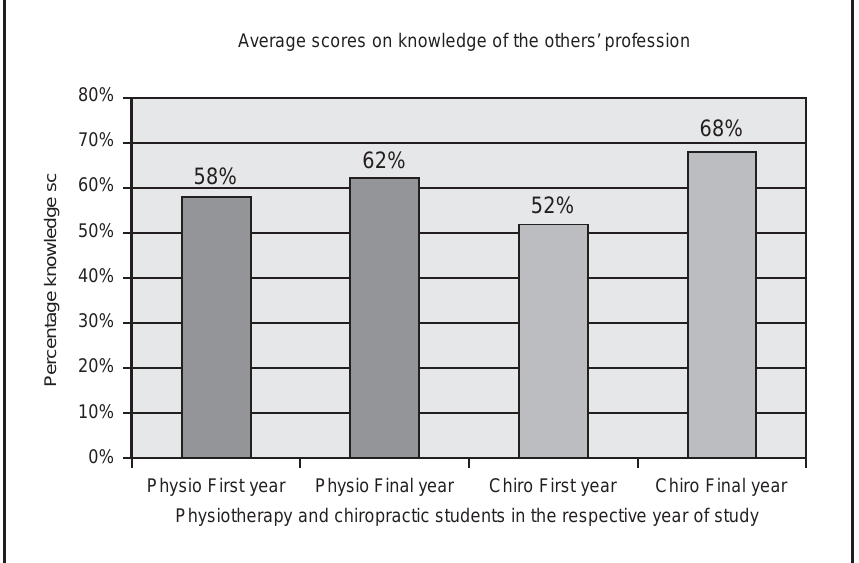
Figure 1: Graph representing the average percentage scored by students for their knowledge of the others’ profession.